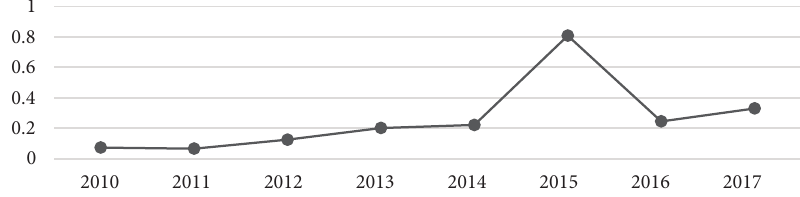
Figure 3. Economic decisions rationality index during 2010–2017 (source: authors’ calculations)